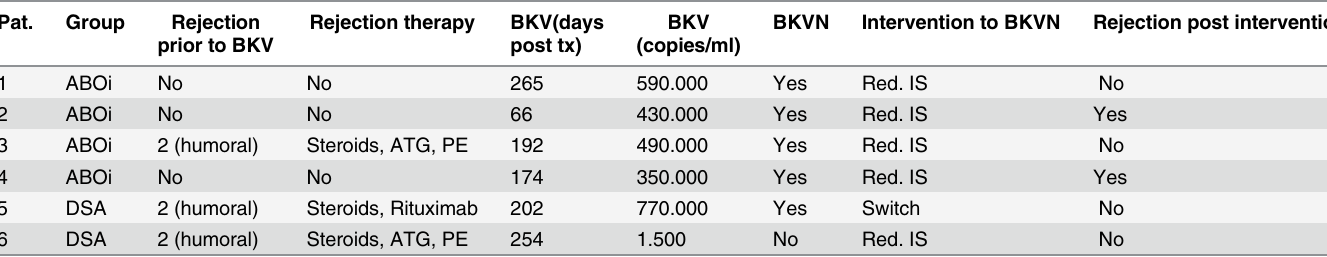
Table 4. Clinical characteristics in patients with BKV. Pat.